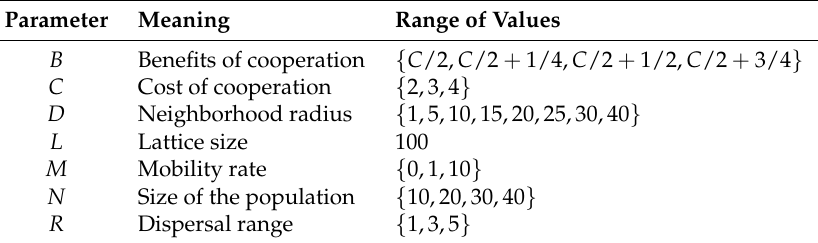
Table 1. Summary of the parameters of the